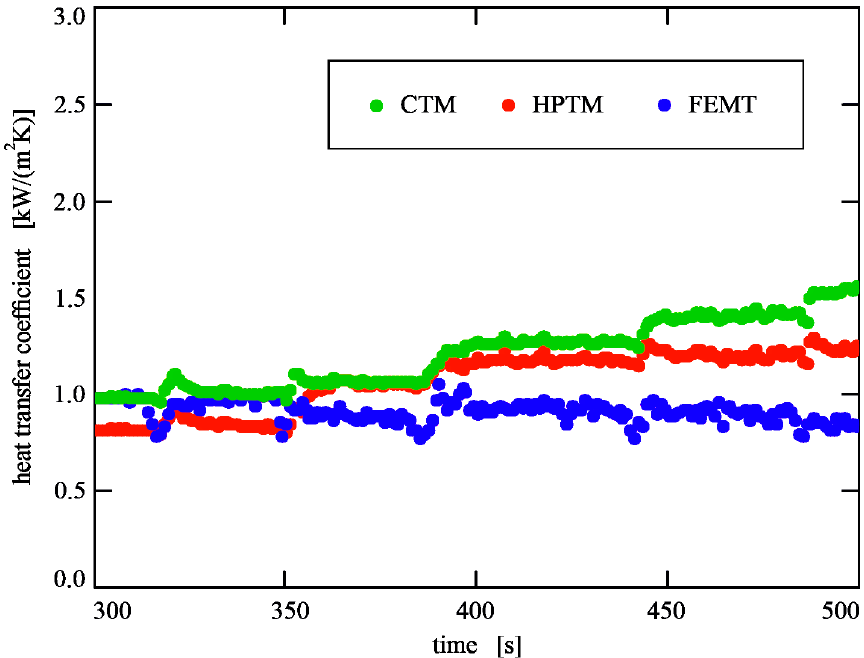
Figure 11. Heat transfer coefficient versus time, the distance from the mini-channel inlet x = 0.0178 m; other experimental parameters are listed in Table 1.